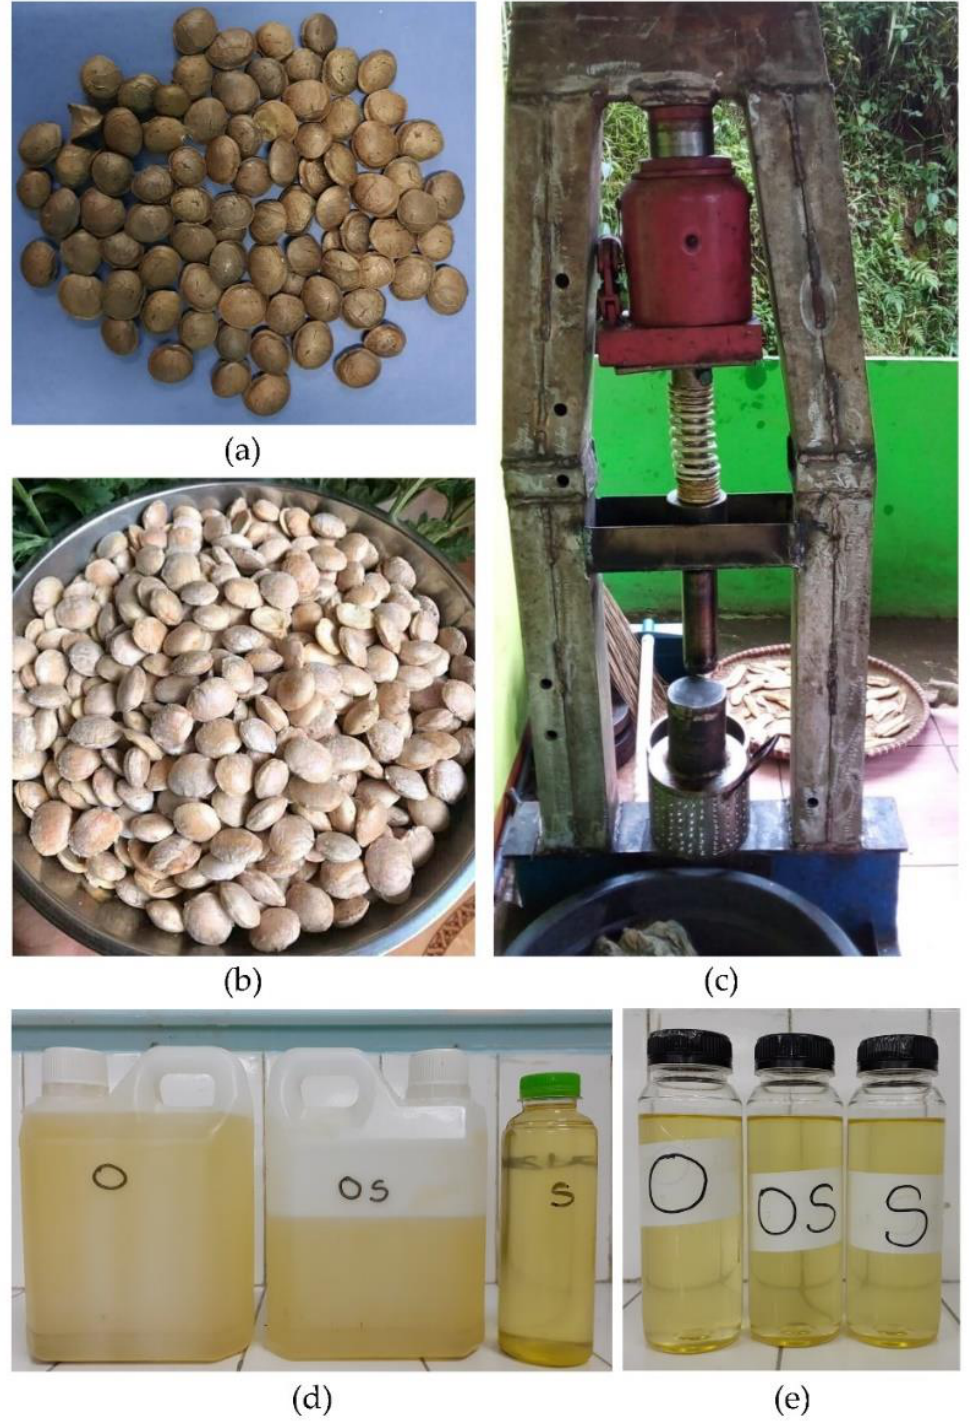
Figure 3. Sacha Inchi oil extraction. ( a ) Sacha Inchi seeds with shell and ( b ) kernel or seeds without the shell. ( c ) Sacha Inchi oil extraction by using a cold-press machine. ( d ) Sacha Inchi oil before filtering and ( e ) after filtering, for oil quality analysis. ( d , e ) O: Open area; OS: Mixed cultures; S: Agroforestry.